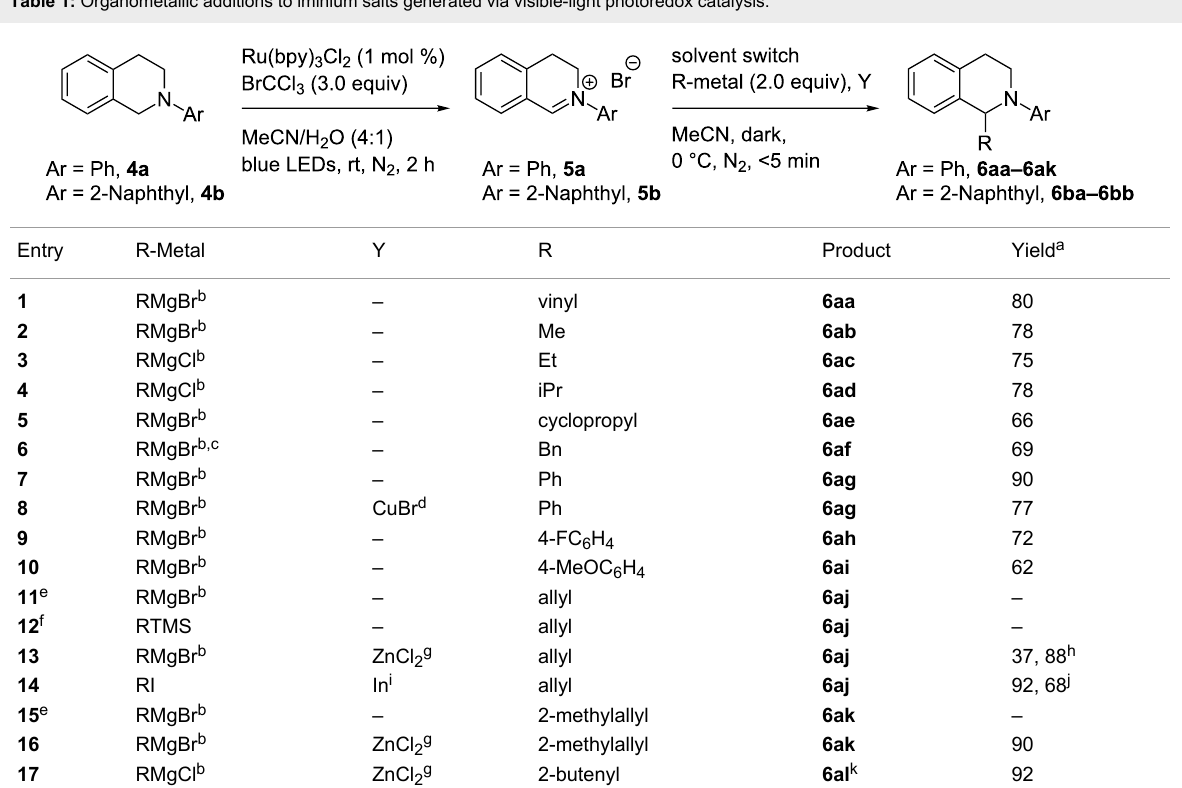
Table 1: Organometallic additions to iminium salts generated via visible-light photoredox